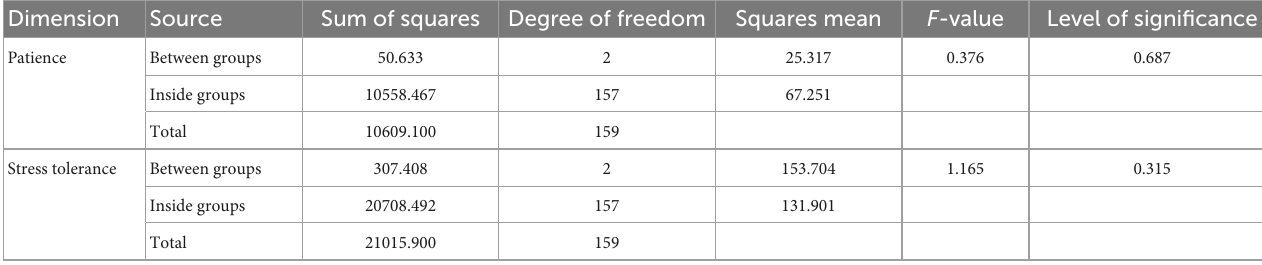
TABLE 6 One way ANOVA analysis of the differences in the degree of patience and stress tolerance, due to profession. Dimension